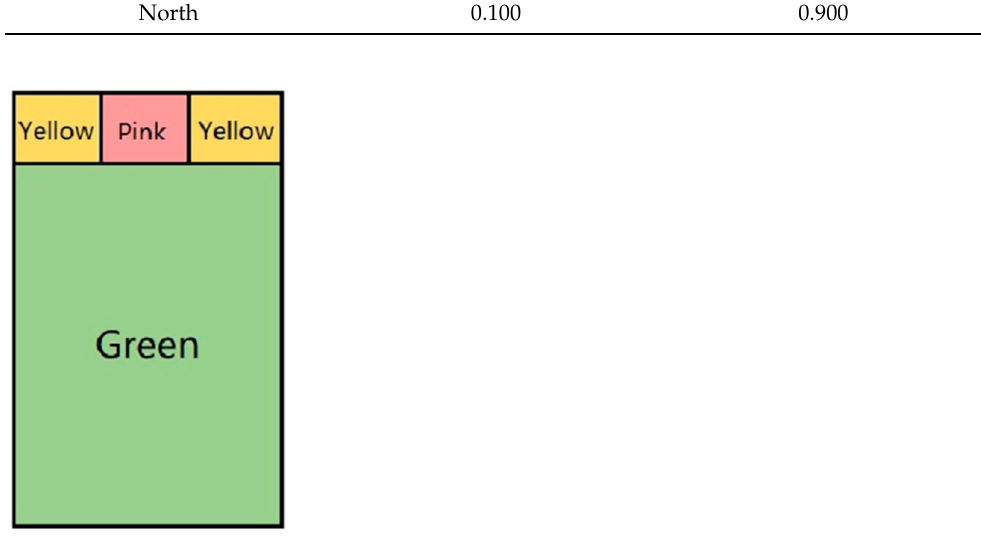
Figure 12. The priority domain distribution of the sensor locations in the north-facing room.